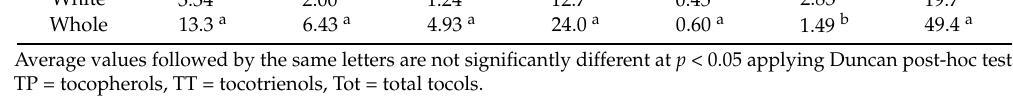
Table 3. Total tocol content (mg kg − 1 ) mean values of ten cultivars in three locations in white and whole